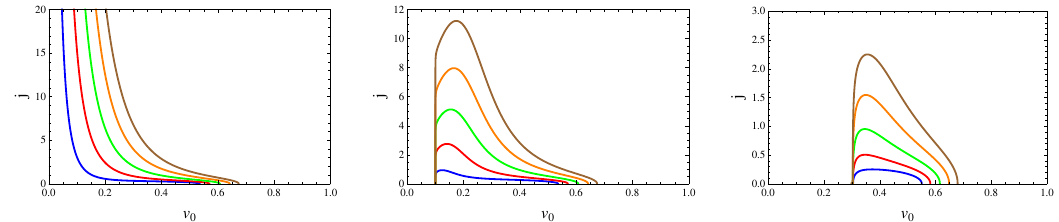
Figure 3 . The supercurrent j as a function of v 0 for (cid:12)ve di(cid:11)erent values of the magnetic (cid:12)eld b = 0 : 1 (blue), b = 0 : 2 (red), b = 0 : 3 (green), b = 0 : 4 (orange) and b = 0 : 5 (brown). The left, center and right panels correspond to v T = 0, v T = 0 : 1 and v T = 0 : 3,